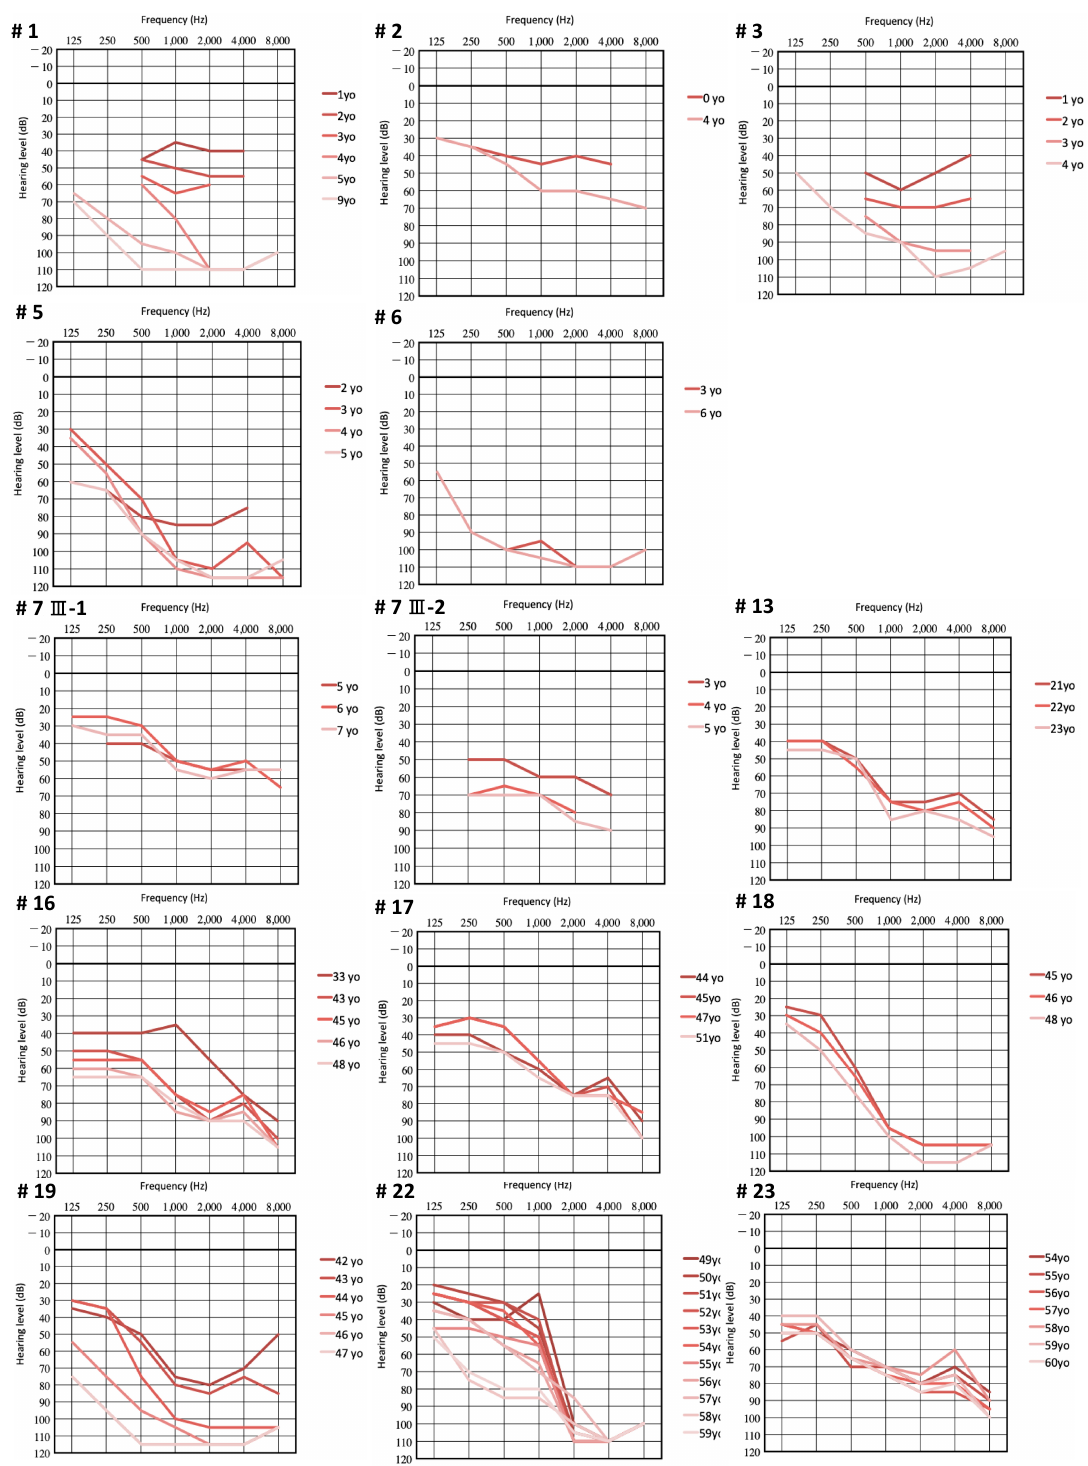
Figure 2. Serial audiograms of eight individuals with LOXHD1 variations. Darker colors indicate the hearing thresholds in younger ages, and lighter colors indicate those in older ages.